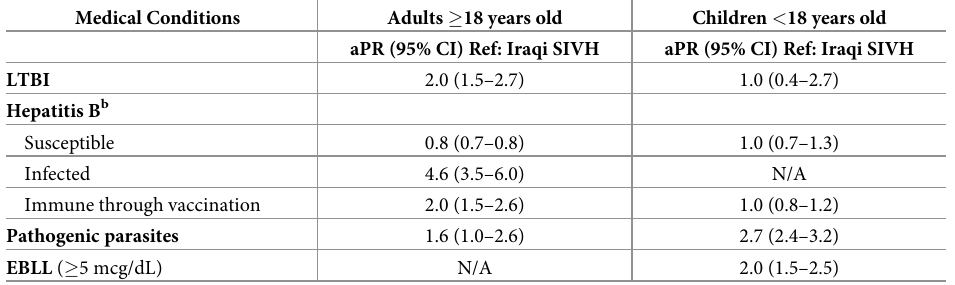
Table 3. Adjusted PRs for select medical conditions comparing Afghan and Iraqi Special Immigrant Visa Holders (SIVH) who resettled to the US, 2014–2016 a